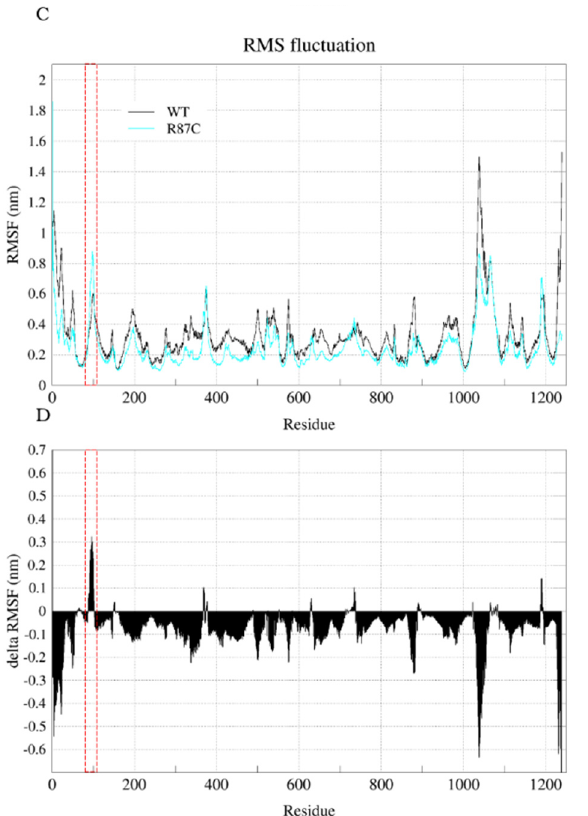
Figure 5. RMSF (calculated with reference to the average structure fitting of C-alphas for the entire structure through the entire trajectory) and delta RMSF for CYFIP2. Root-mean-square fluctuation (RMSF) for each residue (( A )—complex and ( C )—isolated CYFIP2). The delta RMSF values (( B )— complex and ( D )—isolated CYFIP2) were calculated based on the difference in RMSF for each residue (mean of both replicas) in the R87C simulation and the WT simulation. Positive values along the sequence indicate an increase in the flexibility in the mutant. Data for complex WT simulation are represented by dark (first replica) and light (second replica) gray lines. Data for complex R87C simulation are represented by dark (first replica) and light (second replica) cyan lines. Data for the CYFIP2 WT simulation are represented by black lines. Data for the CYFIP2 R87C simulation are represented by cyan lines. Red box highlights the region between residues 80–110 in all